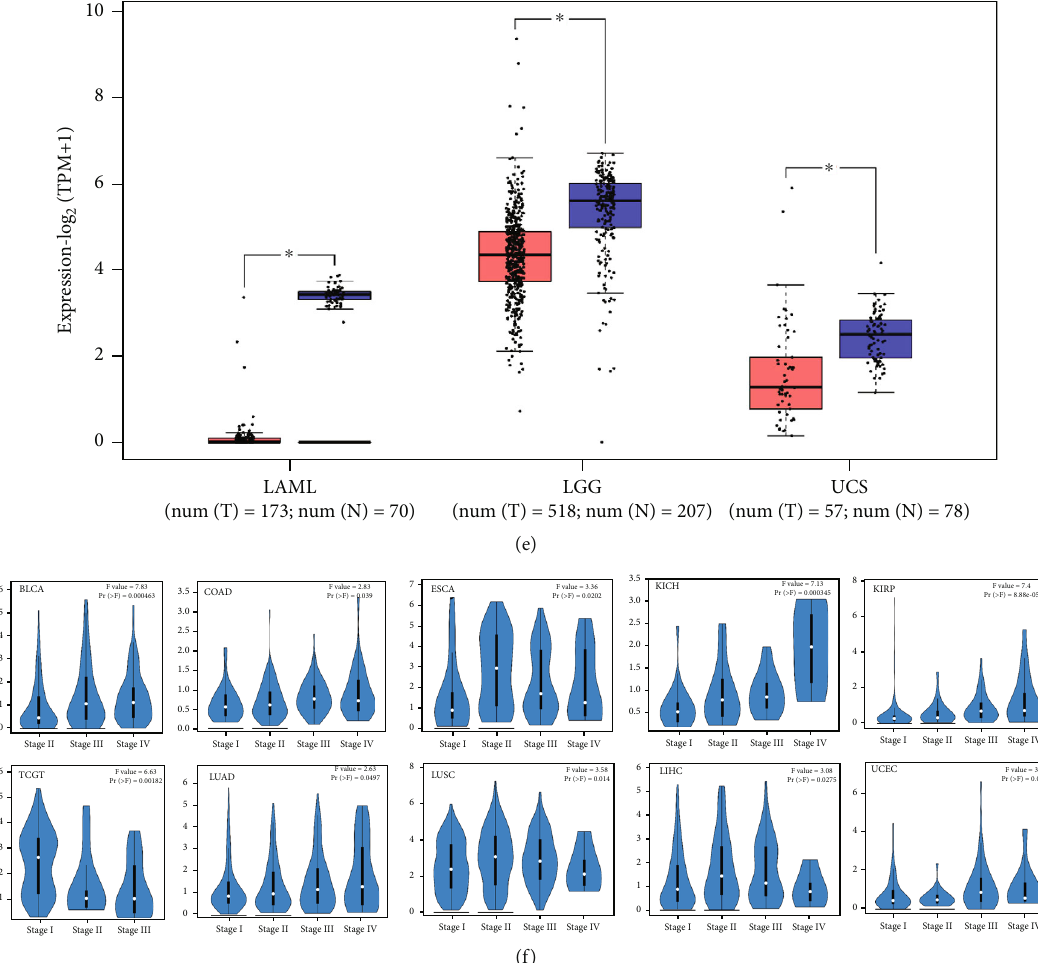
Figure 1: The expression levels of B4GALNT1 across cancers. (a) Data of GTEx database showed the expression levels of B4GALNT1 in normal tissues. (b) Data of CCLE database showed the expression levels of B4GALNT1 across di ff erent cancer lines. (c) Data of TCGA and GTEx database showed the expression of B4GALNT1 in diverse tumors and normal tissues. (d) Data of TCGA database using TIMER2 approach showed the expression levels of B4GALNT1 across multiple tumors and normal tissues. (e) Data of GTEx comparing tumor tissues and normal tissues in LAML LGG and UCS. (f) Data of GEPIA2 showed the expression levels of B4GALNT1 in di ff erent pathological stages of